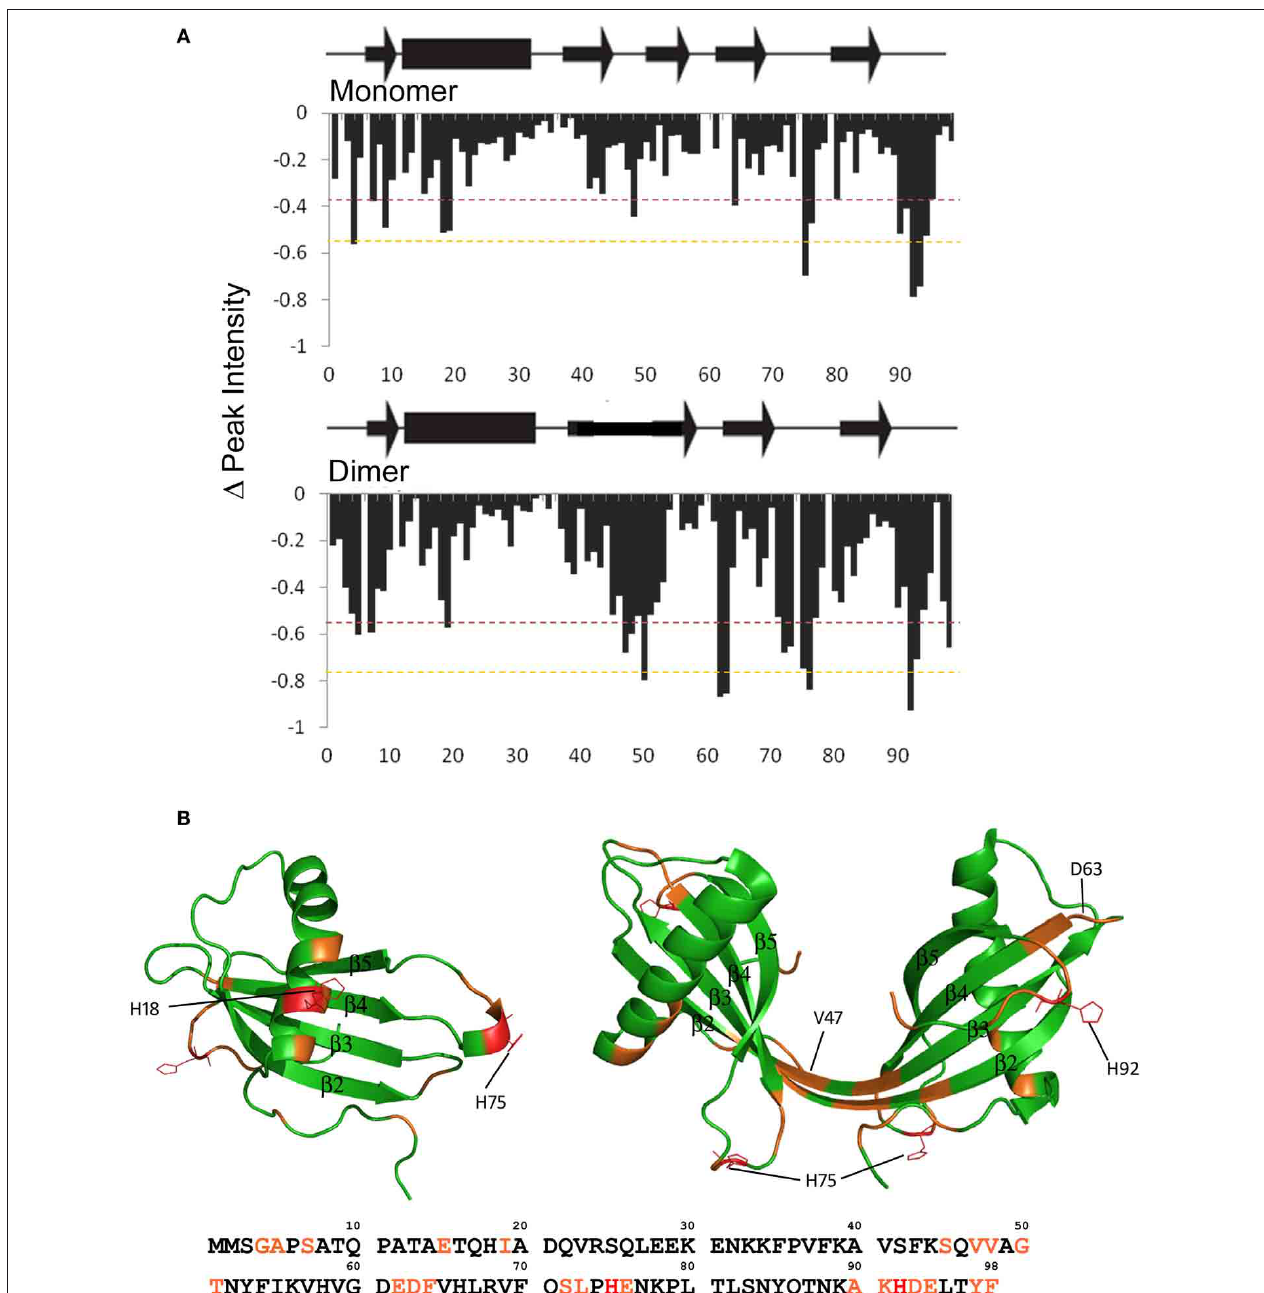
FIGURE 4 | Mapping copper binding sites in soluble stefin B. (A) Changes in the relative intensity of amide NMR signals upon Cu 2 + binding (calculated from the 2D 1 H 15 N HSQC spectra). The dashed lines represent one (red) and two (orange) standard deviations from average intensity changes measured in solution. Changes above